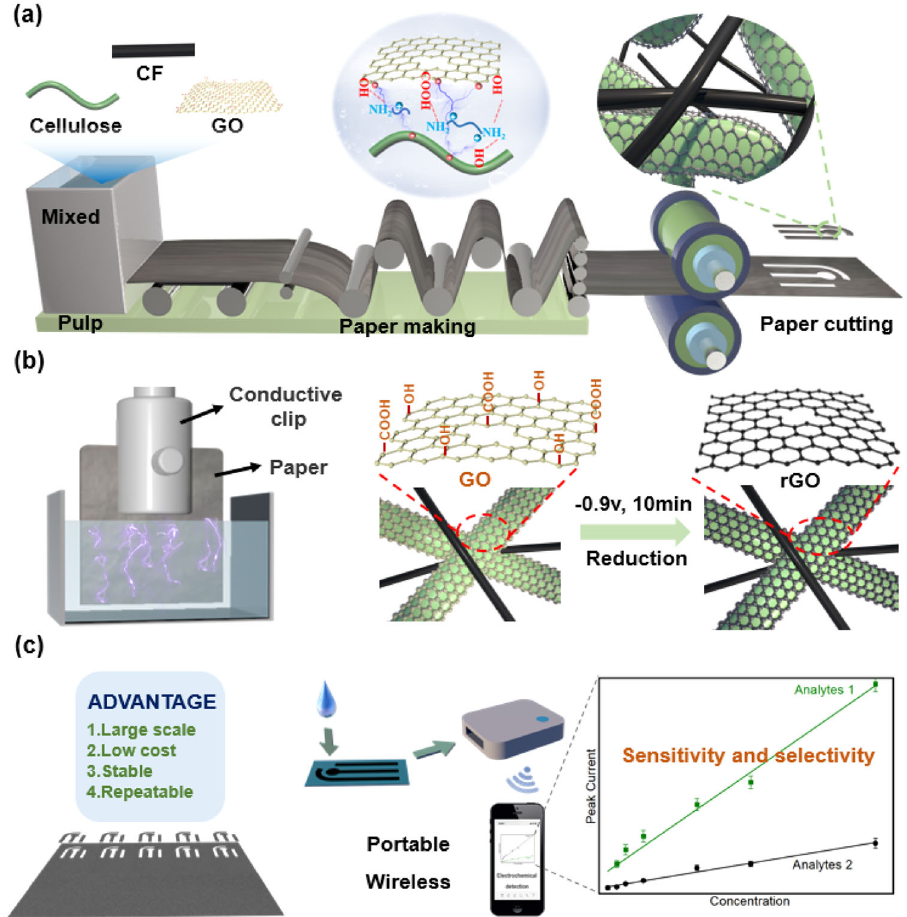
Fig. 1 Large-scale preparation of high-performance paper-based electrochemical sensors. a Large-scale papermaking. By controlling interfacial interactions, composite paper was prepared composed of cellulose, carbon fi bers (CF, confers conductivity) and graphene oxidize (GO, confers electrocatalytic activities). b Electrochemistry reduction of GO. Electrochemistry provides a simple scalable approach to GO reduction. c Vision of paper-based electrochemical sensor. The vision for high-performance and sustainable paper-based sensors for portable electrochemical